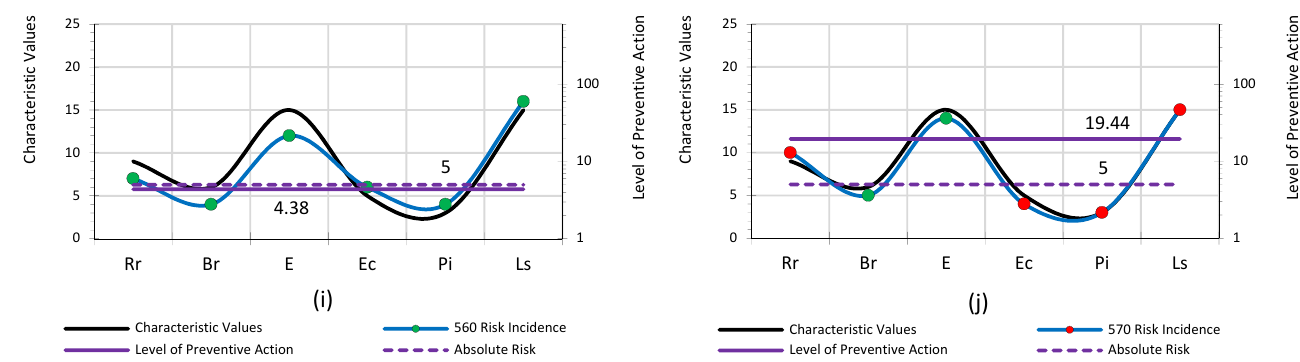
Figure 10. Cvs of incidence of the parameters. Apac : ( a ) Risk-010, ( b ) Risk-020, ( c ) Risk-040, ( d ) Risk-110, ( e ) Risk-350, ( f ) Risk-380, ( g ) Risk-420, ( h ) Risk-440, ( i ) Risk-560, and ( j ) Risk-570.